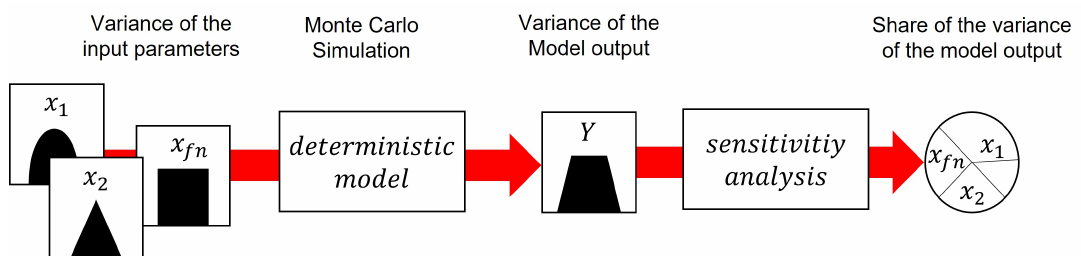
Figure 1. Illustration of a global sensitivity analysis, adapted from